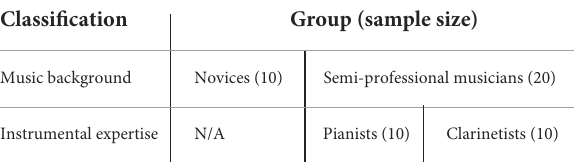
TABLE 1 Classification of participants based on their music training and instrumental